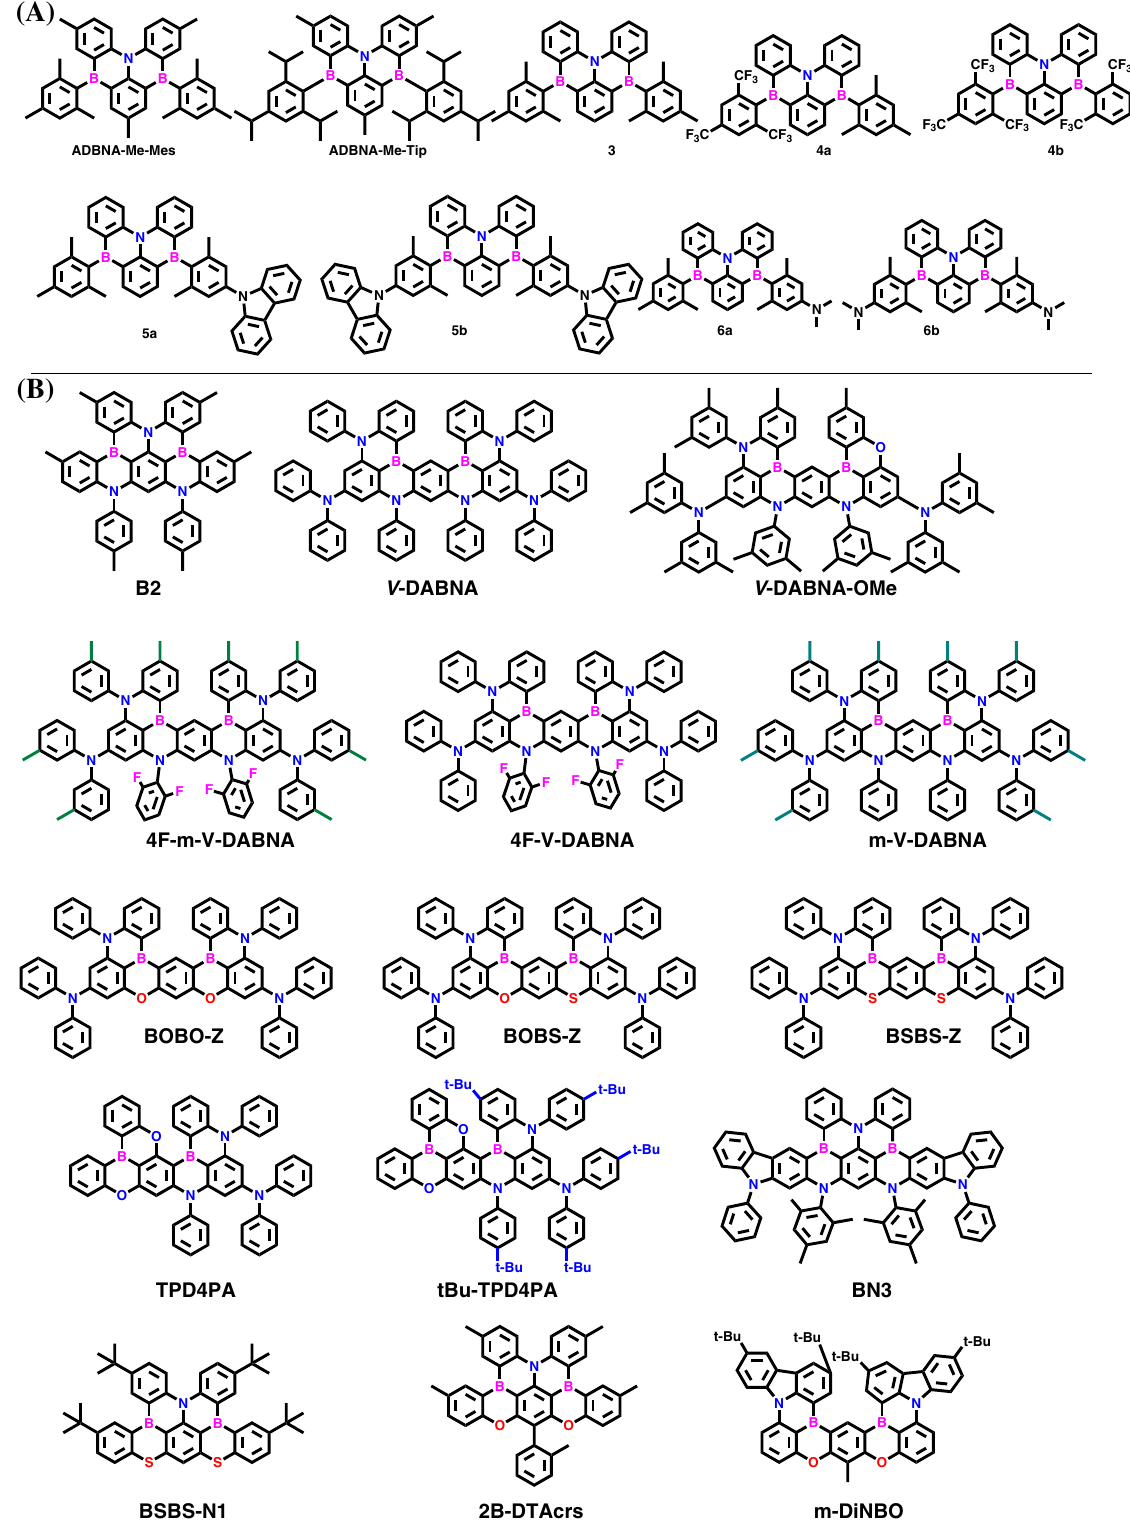
Fig. 2 Chemical structures of ADBNA & ν -DABNA style. Molecular structures of the ( A ) azadiboranaphthoanthracenes (ADBNAs) and ( B ) N7,N7,N13,N13,5,9,11,15-octaphenyl-5,9,11,15-tetrahydro-5,9,11,15-tetraaza-19b,20b-diboradinaphtho[3,2,1-de:1 ′ ,2 ′ ,3 ′ -jk]pentacene-7,13-diamine ( ν -DABNA) style based Blue DB-MR-TADF